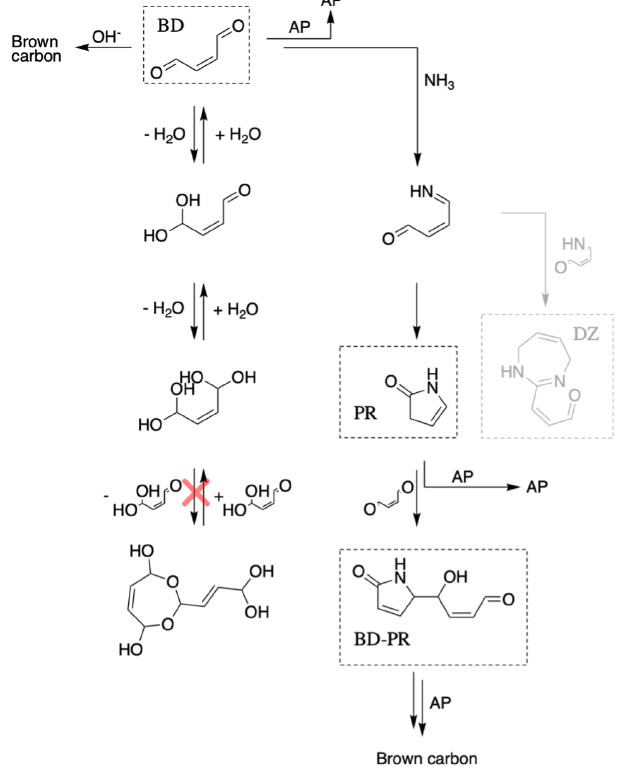
Figure 1. This chemical scheme is proposed for butenedial reac- tivity in an aqueous solution with NH x . Reactions that are grayed out were not explicitly included in the model kinetic mechanism. Butenedial/OH − and butenedial/NH 3 reactions lead to brown car- bon formation through accretion reactions. Accretion reactions with reactants, products, and accretion products (AP) are observed in the butenedial/NH 3 pathway. Acetal oligomer formation is not ob-